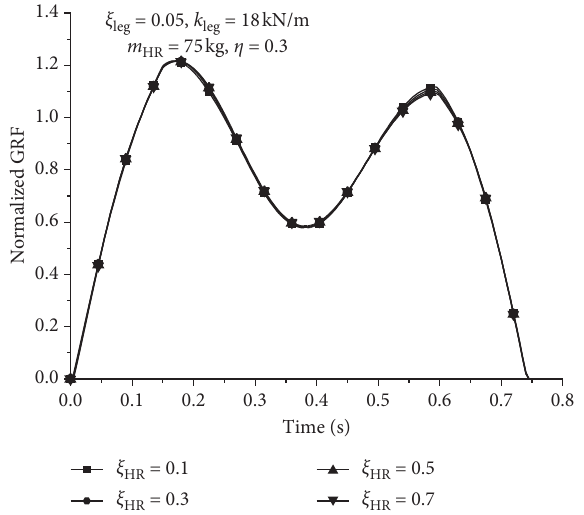
Figure 18: Normalized GRF under different continuum damping ratio.